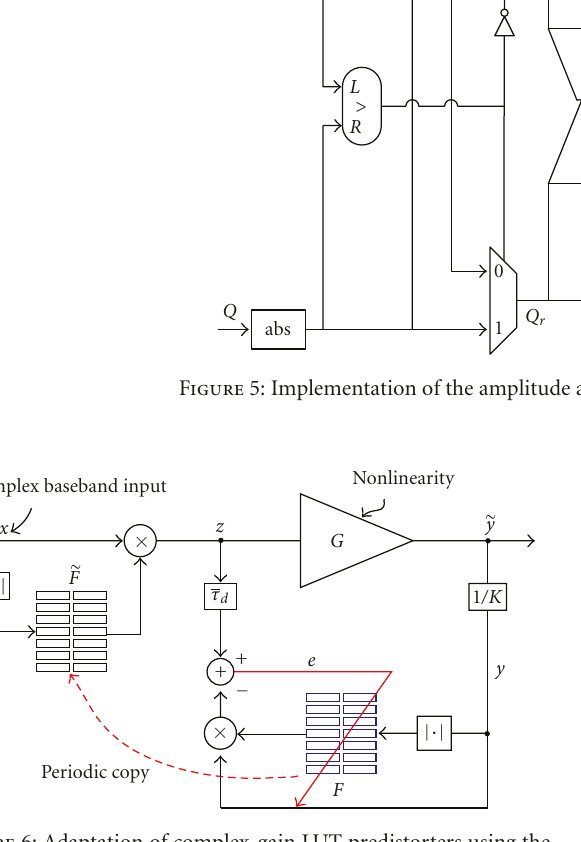
Figure 6: Adaptation of complex-gain LUT predistorters using the indirect learning